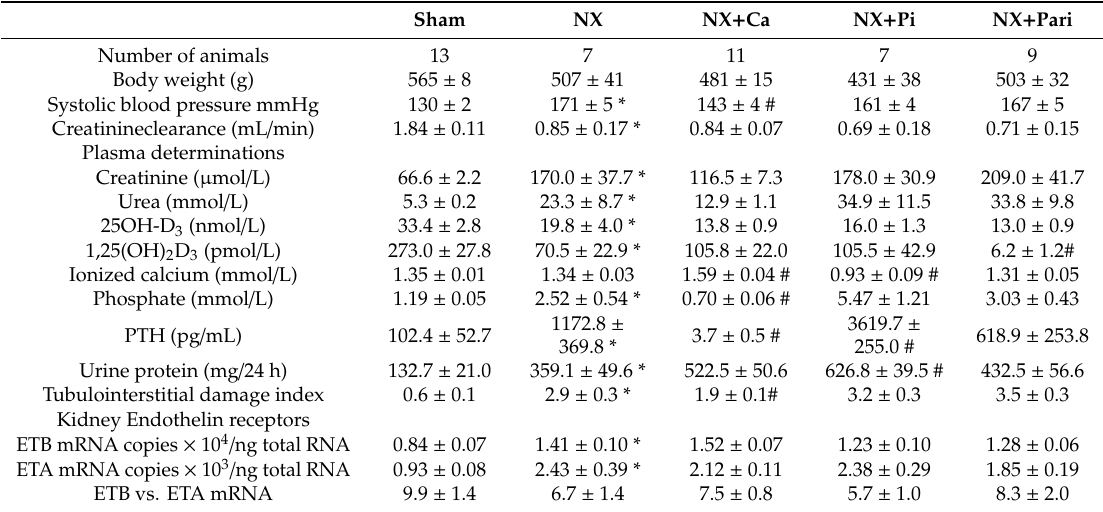
Table 2. Animal data and laboratory findings at the end of the twenty-seven-week 5 / 6 nephrectomy